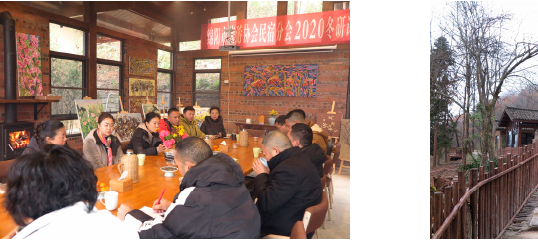
Figure 10. Seminar of rural homestay branch of tourism association in Mianyang and the rural homestay in Pingwu and Anzhou in Mianyang (Photo by author).